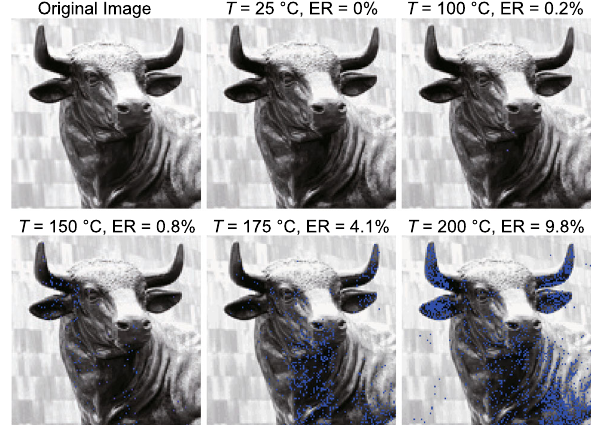
Fig. 9 Transmitted image data. The retrieved 5-bit grayscale image encoded in a 32-level SPDPSK system sent through a free-space channel with various turbulence strengths. The blue pixels indicate the incorrect data received, and the error rate of each image is listed on the top.